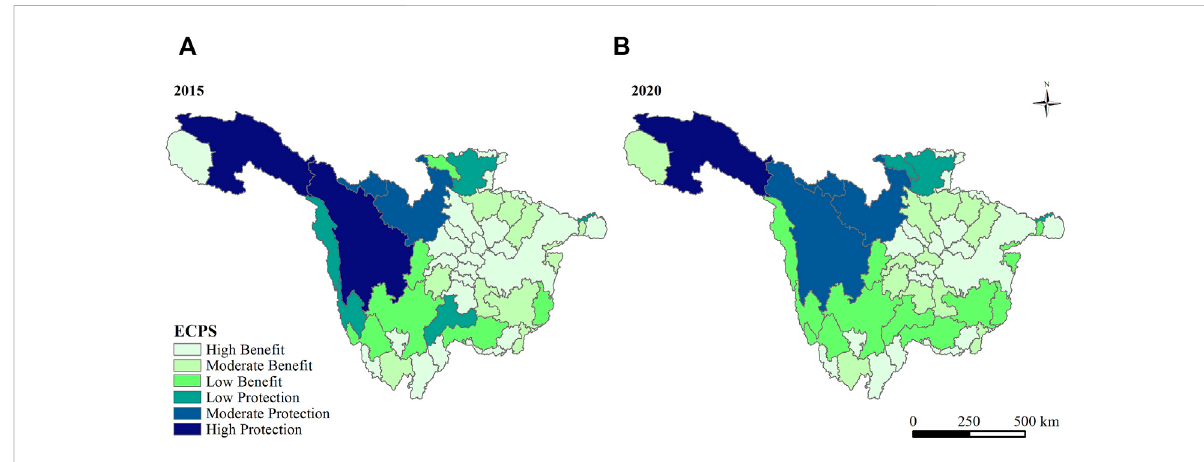
FIGURE 6 The upper Yangtze River eco-compensation priority sequence. (A) ECPS in prefecture-level cities in 2015; (B) ECPS in prefecture-level cities in 2020.